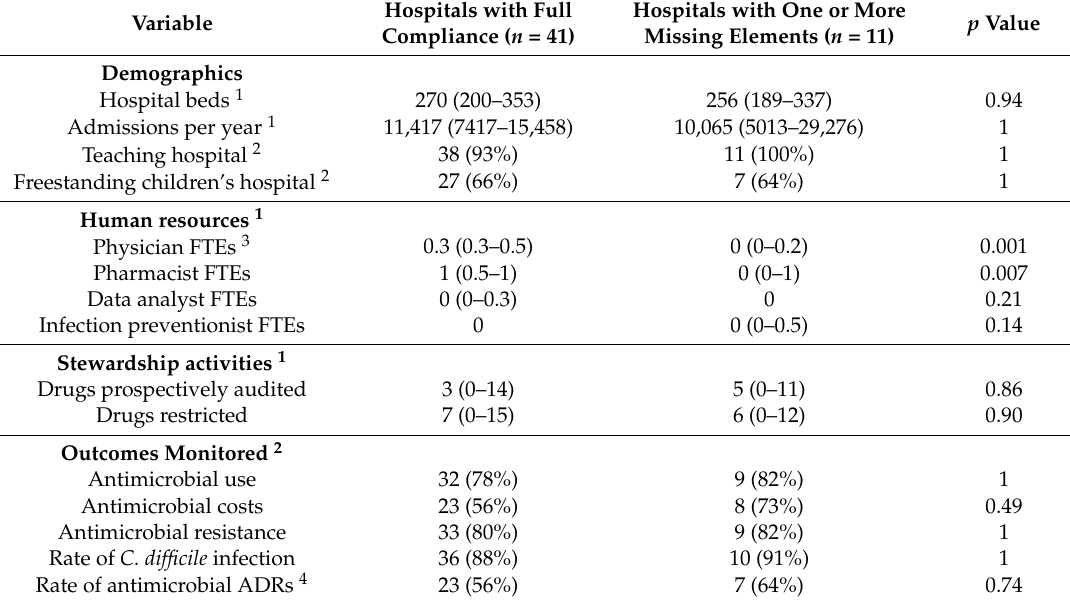
Table 3. Demographic Data of Hospitals stratified by Compliance with Centers for Disease Control and Prevention’s (CDC) Core